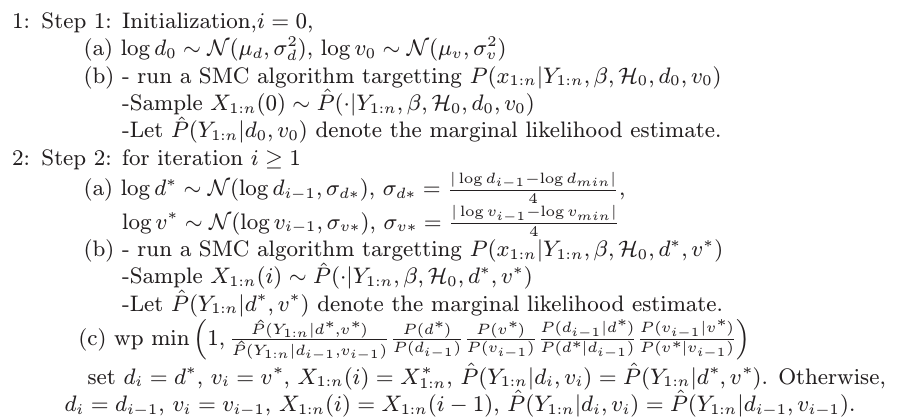
Algorithm 5 Particle marginal Metropolis-Hastings sampler